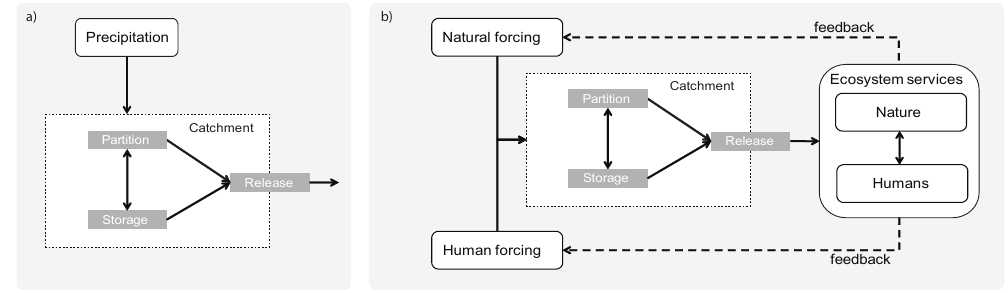
Fig. 1. (a) The catchment and its function, viewed as a system with fixed structure and precipitation as exogenous forcing (adapted from Wagener et al., 2007, with the permission of the authors); (b) the catchment as part of an evolving ecosystem, which provides services and feeds back on the human and natural